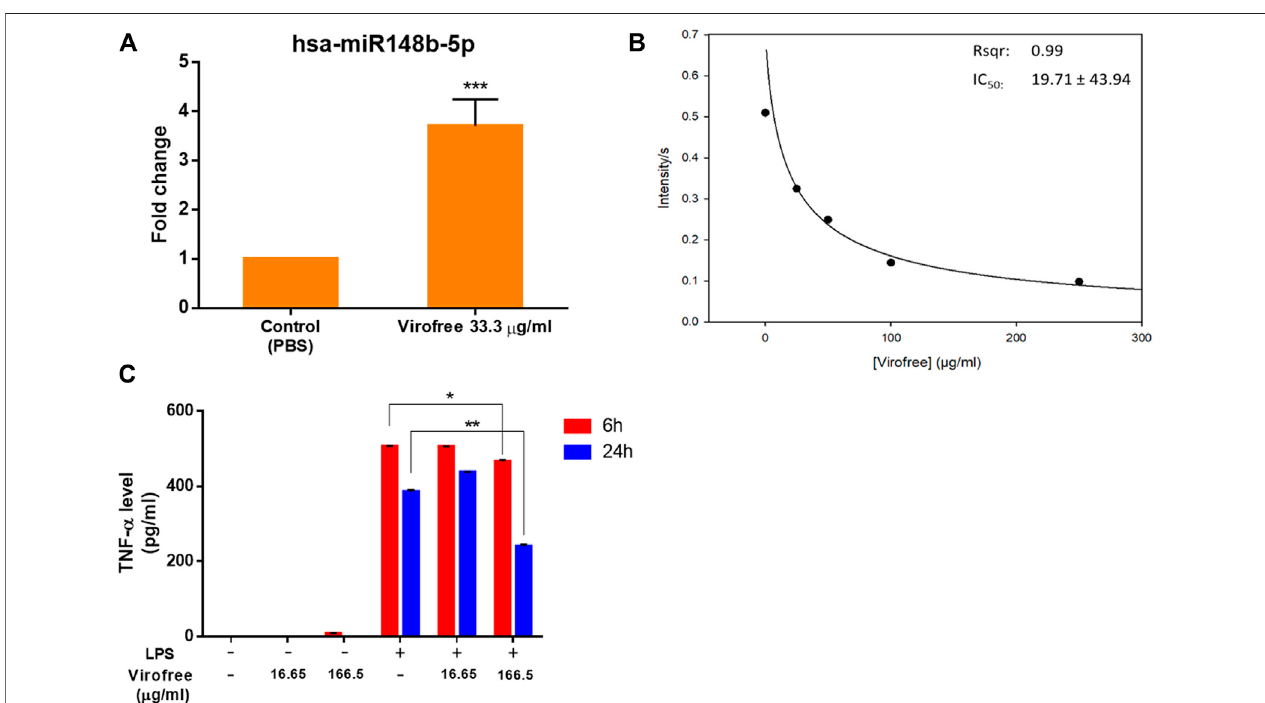
FIGURE2| Virofreecanpotentiallyreduceviralreplicationbyinducing miR-148b-5p ,inhibitingM pro ,andsuppressingcytokinestorm. (A) miR-148b-5p expression levels were measured by qRT-PCR after 24 h of treatment with 33.3 μ g/ml of Virofree ( n = 3). All data are presented as means ± SD. (B) Virofree IC 50 of inhibiting recombinant SARS-CoV-2M pro wasdeterminedand showed (µg/ml). (C) after treating PMA-differentiated THP-1 cellsfor 6or24 h, the cellmedium wascollected,and then ELISA was used to measure the amount of cytokine release. Treatment of LPS 100 ng/ml alone in differentiated THP-1 cells was considered as the positive control ( n = 3). All data are presented as means ± SD. Statistical analysis was carried out with one-way ANOVA. * or **: signi fi cantly different from the corresponding control, respectively, with p < 0.05 or